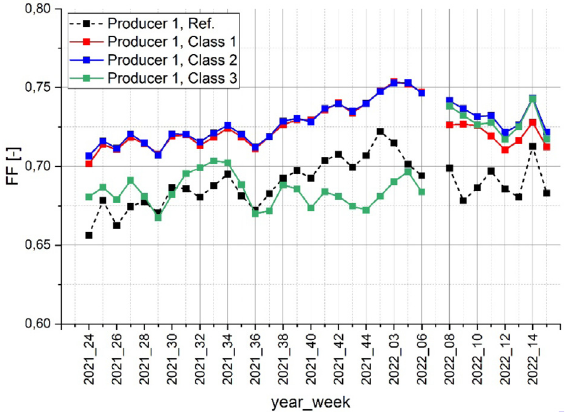
Fig. 10. Weekly mean fi ll factor (FF) per string group for high irradiance classes (800 – 1000 W/m 2 ); for week 7 in 2022 (2022_07) there are no data shown due to deinstallation of the modules for indoor characterization.